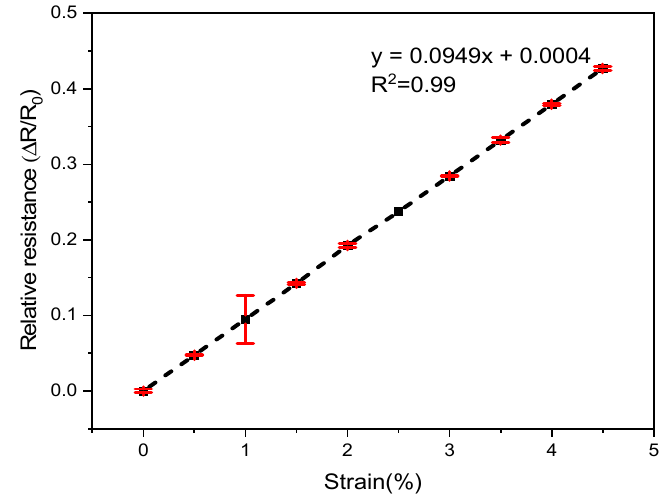
Figure 9. Effects of strain on electrical resistance.